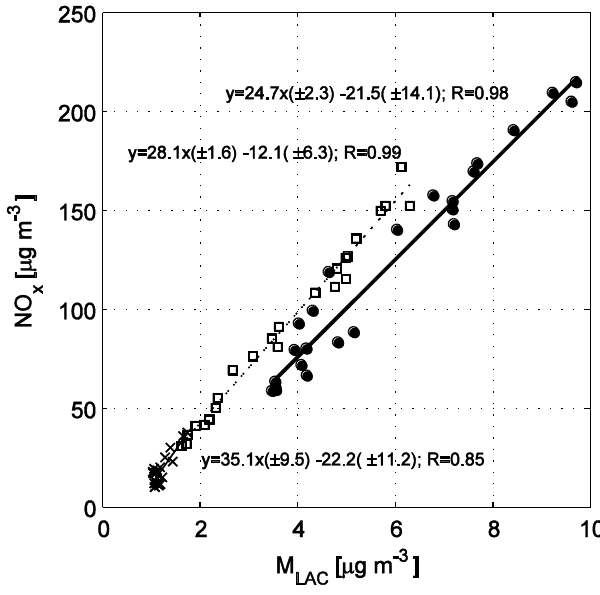
Fig. 9 Fig. 9. Scatterplot of M LAC versus NO x weekday diurnal varia- tion concentrations for three sites (black dot: Hornsgatan, square: Essingeleden, cross: Torkel) in the period 20 April–5 July 2006, excluding the LRT event. The regression equation with the 95% confidence intervals for the slope and y-intercept, and correlation coefficient R are also displayed.